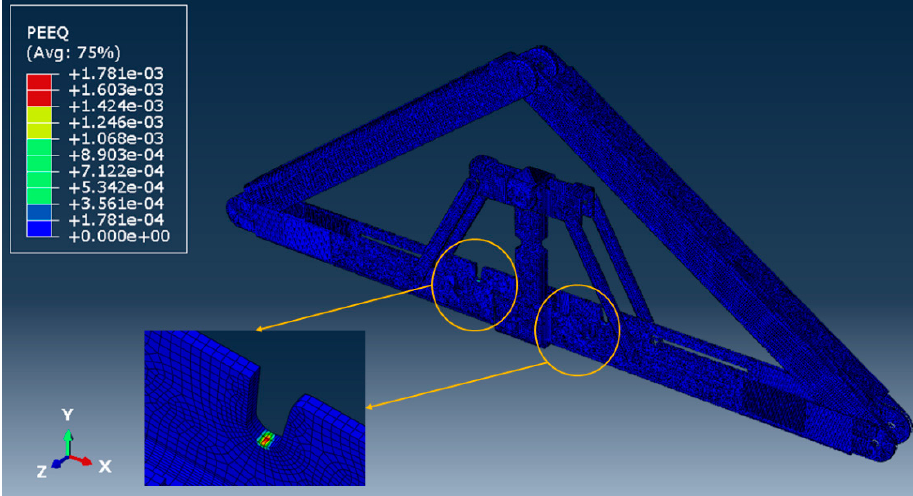
Figure 33. Stress (MPa) for partial wind load case uplift (hourly wind pressure= 0.85 kPa).